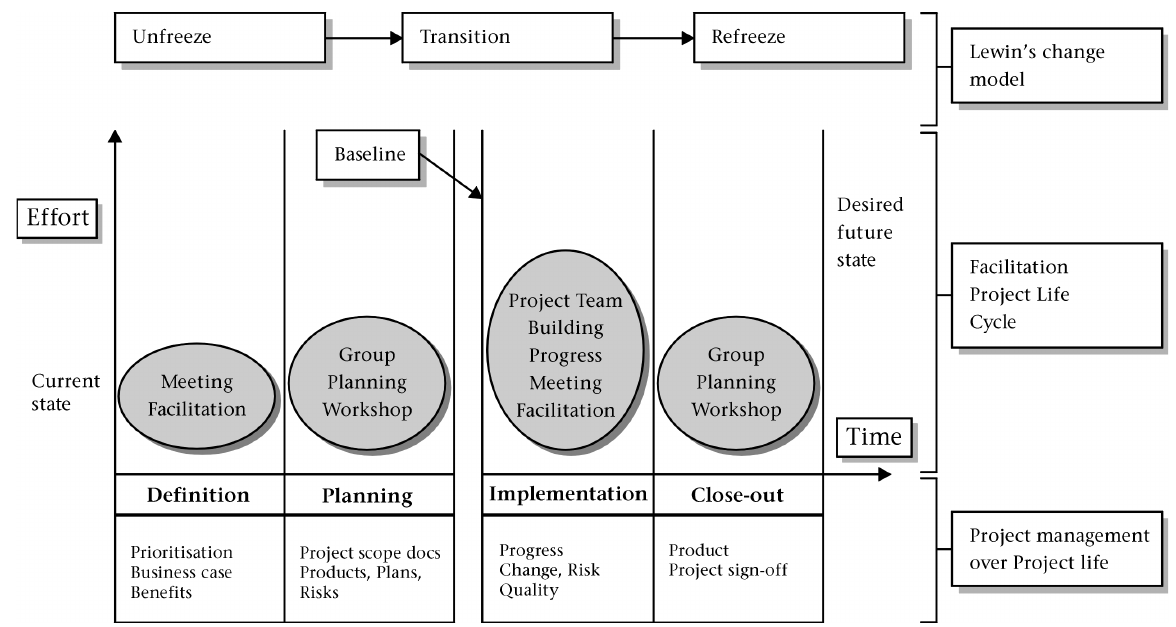
Figure 4: Integrating facilitation skills with project management phases to combine systematic and interactive aspects of change – Facilitative project management model version